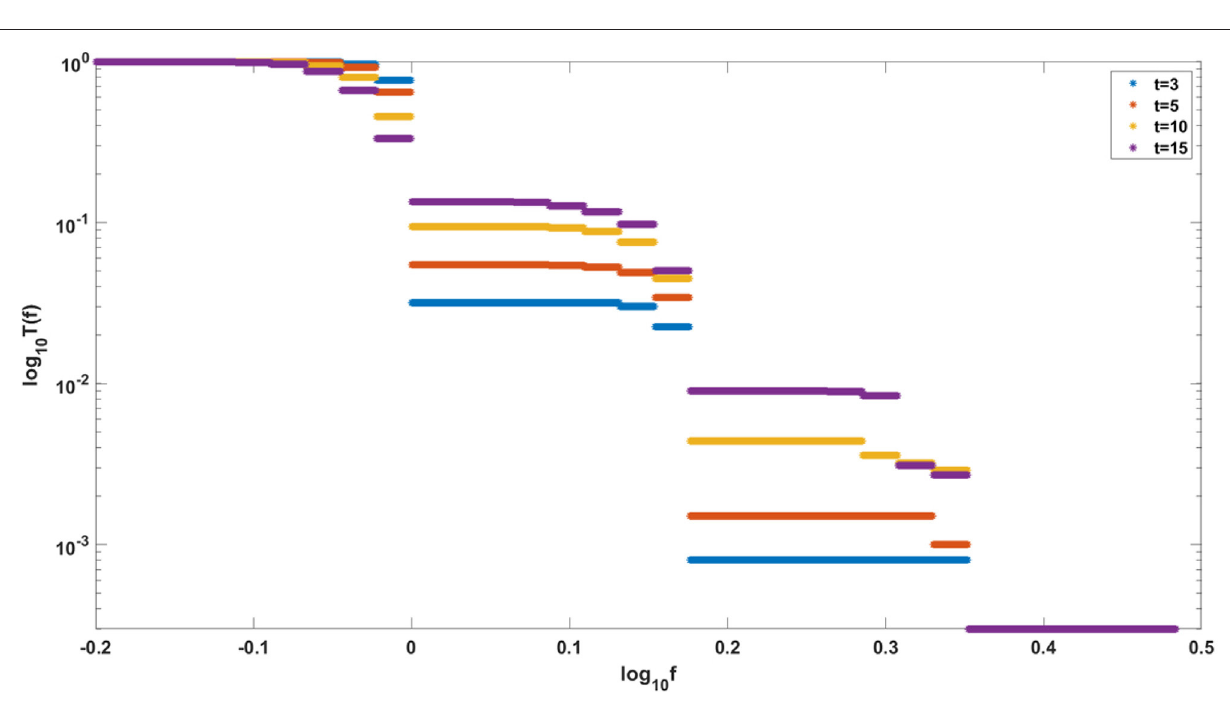
FIGURE 15 | Evolution of clones with increasing fitness, according to Model A. Depicted are logarithmic cumulative distribution tails log 10 T ( f ) of logarithmic fitness log 10 f , for a series of times t = 3,5,10,15. Parameter values, s = 0.5, d = 0.05, p = 0.1, L = N µ =